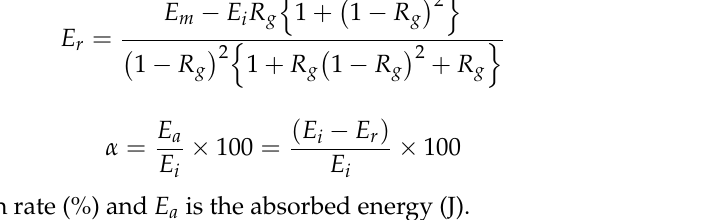
Table 2. Variation of concave dimensions with applied load.